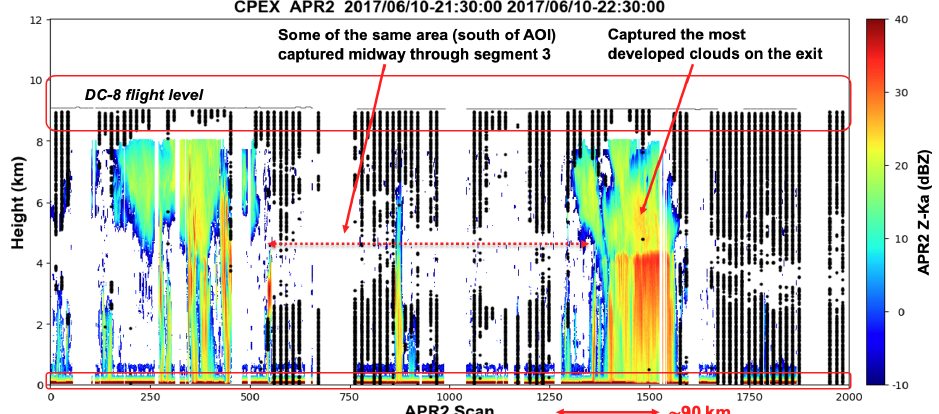
Figure 18. Cross section of the APR-2 Ka-band reflectivity (color scale to right) during segment 4 (21:30–22:30UTC). Same layout and format as Fig. 8.